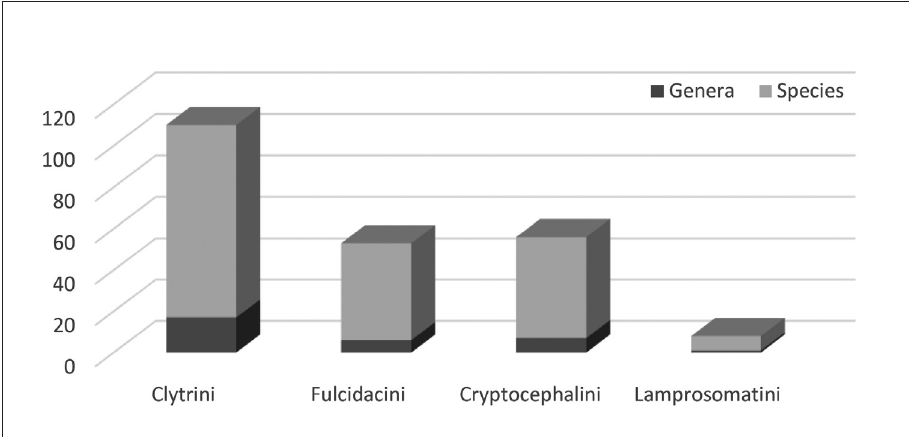
Figure 38. Bars diagram showing the number of genera and species by tribe of Argentinian Camptosomata. dients hypothesis with greater species richness at tropical latitudes (Hillebrand